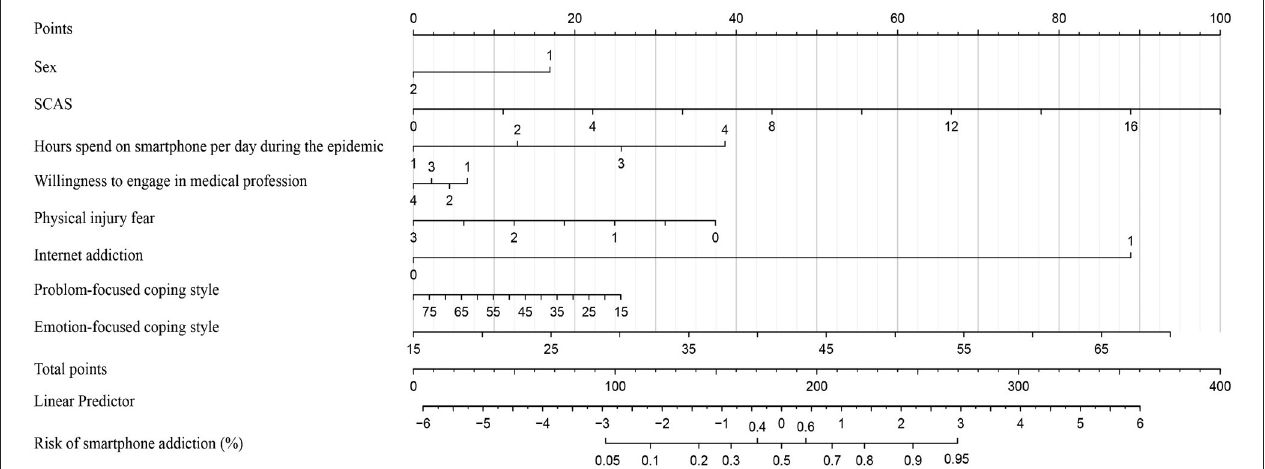
FIGURE 1 | Nomogram for prediction the risk of smartphone addiction. Points for sex, levels of clinical anxiety symptoms (total scores of SCAS), hours spend on smartphone per day during epidemic, willingness to engage in medical profession, physical injury fear, levels of Internet addiction and emotion/problem-focused coping style can be obtained by calibrating with the point caliper, and then combined to obtain a total score that can be calibrated with the cumulative risk of smartphone addiction (%). The assignment values of each classified variable were: sex, 1 = female; 2 = male; hours spend on smartphone per day during the